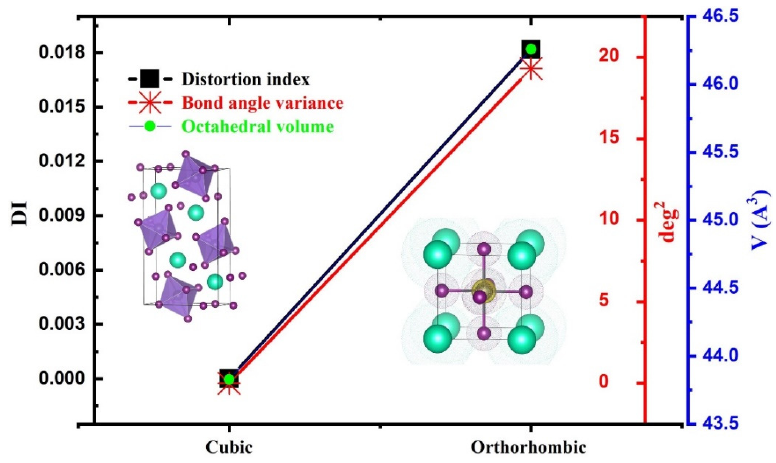
Figure 5. Calculated average PbI 6 octahedral volume, average distortion index (bond length), and bond angle variance of CsPbI 3 for the cubic and orthorhombic phases.